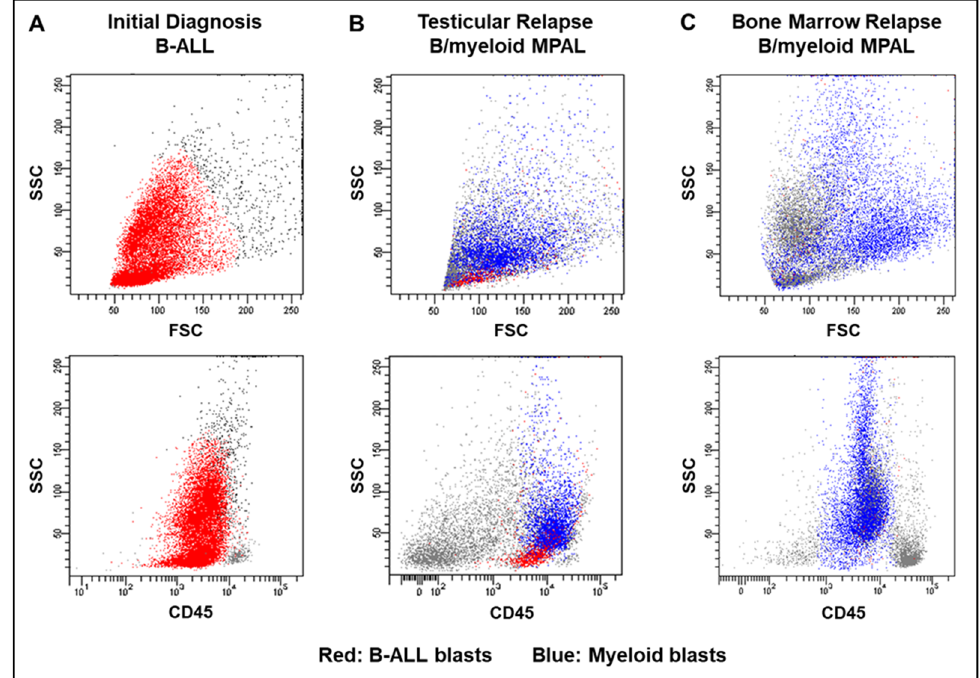
Figure 2. Flow cytometry dot plot representation of the patient’s leukemia at various time points and across different sites of disease. The top three panels demonstrate the patient’s leukemia blasts along the side scatter (SSC) vs. forward scatter (FSC) axis at ( A ) initial diagnosis, ( B ) testicular relapse, and ( C ) first bone marrow relapse, whereas the bottom three panels depict the blasts along the SSC vs. CD45 axis at the same time points. B-ALL blasts are represented in red, while the myeloid lineage blasts are depicted in blue.